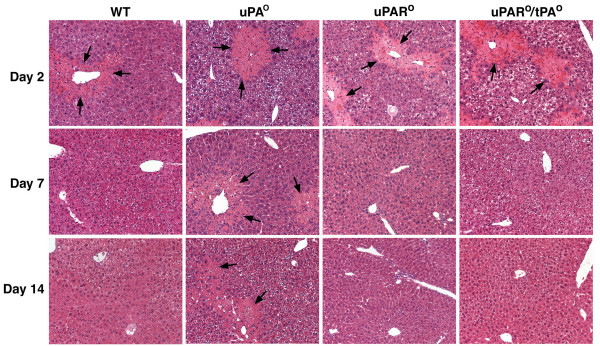
Impaired resolution of centrilobular injury in mice lacking receptor-free uPA. Histological liver sections 2 days after CCl4 show similar features of centrilobular necrosis (arrows) in mice of all genotypes. While livers from wild type (WT), uPAR°, and uPAR°/tPA° show resolution of the centrilobular injury by day 7, uPA° livers continue to display the injury at 7 and 14 days after CCl4 despite the presence of uPAR (Magnification 200×)